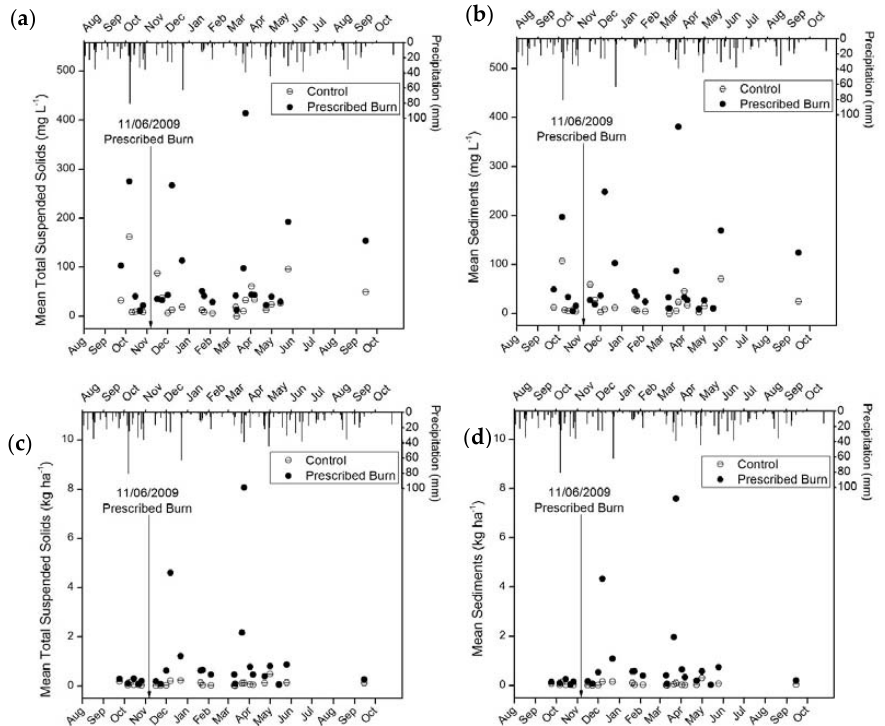
Figure 8. Scatter plots for means from 24 runoff collection events for ( a ) total suspended solids concentration; ( b ) sediments concentration; ( c ) total suspended solids loads; and ( d ) sediment loads data by treatments combined by watersheds.